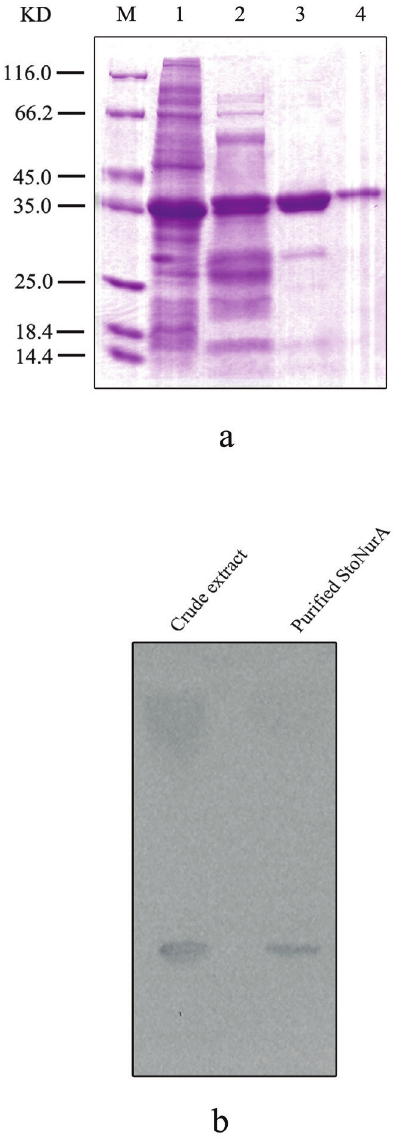
Figure 1 - (a) SDS-PAGE of StoNurA. Lanes M, molecular weight stardards; Lane 1, crude cell extract; Lane 2, supermatant after heat-treatment for 30 minutes at 70 °C; Lane 3, the partially purified enzyme after nickel column; Lane 4, the purified enzyme after gel filtration chromatography. ( b ) Identification of StoNurA in S. tokodaii cells. S. tokodaii cell extracts (100 µg) and purified StoNurA (50 ng) were seperated by 12% SDS-PAGE gels. These gels were subjected to Western blot analyses with anti- StoNurA polyclonal antibodies to detect StoNurA. (see the colors in the online